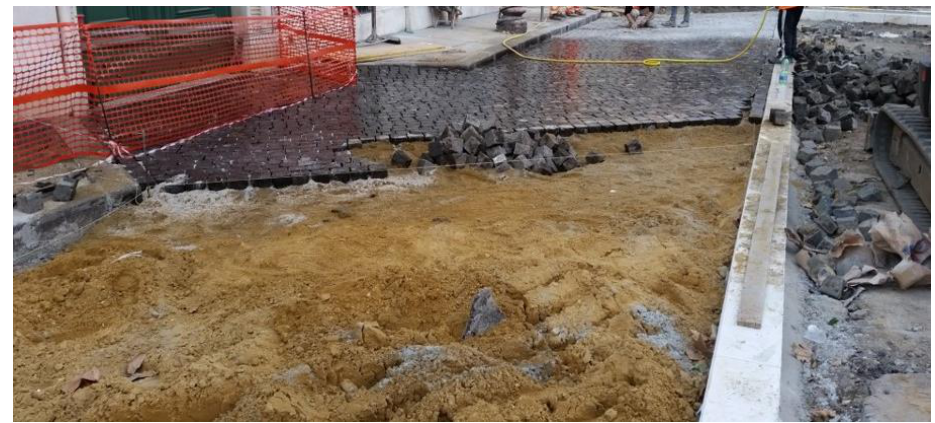
Figure 8. Sampietrini pavement under construction.